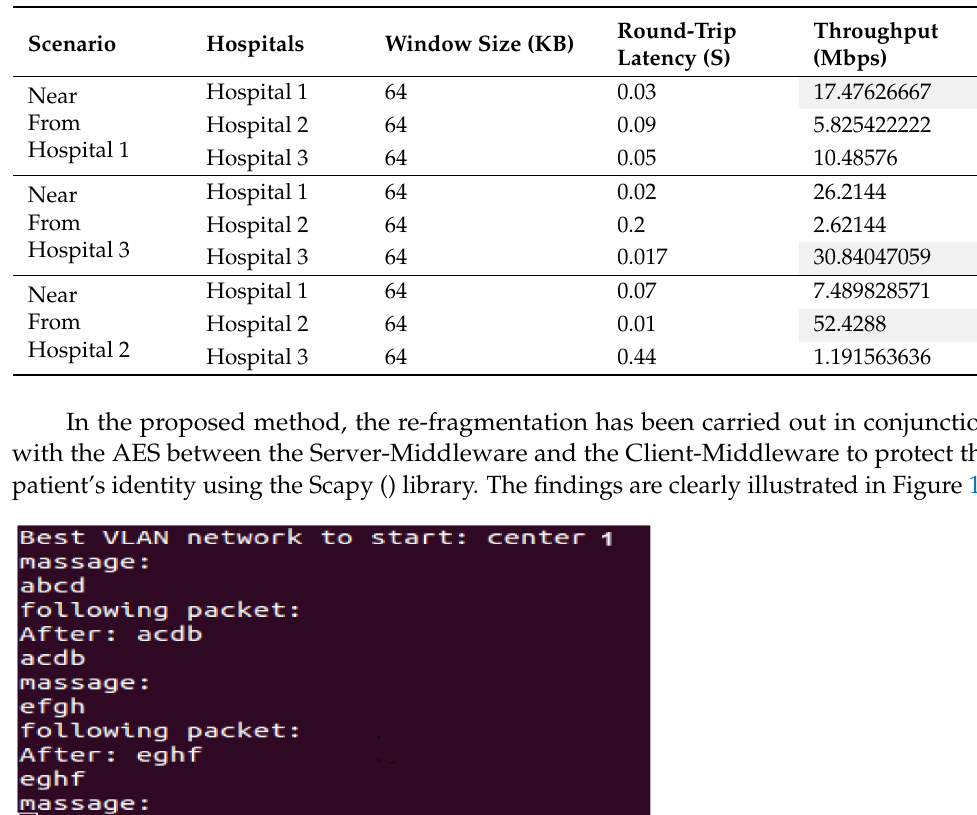
Figure 10. The system sends and receives test signals to choose a suitable network. Table 3. Throughput theoretical calculation for the long distance of the